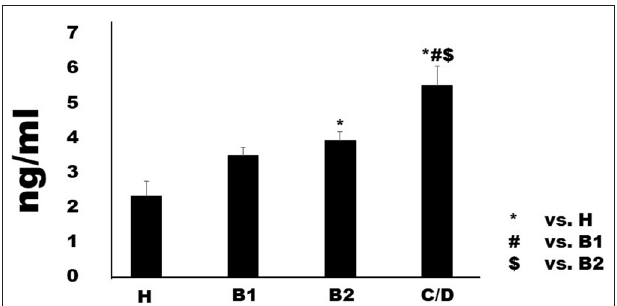
FIGURE 1 | Serum concentrations of intestinal fatty-acid binding protein in healthy Chihuahuas (H) and Chihuahuas with myxomatous mitral valve disease divided into three groups (B1, B2, and C/D). One-way ANOVA with post hoc Turkey-Kramer test. Significant difference was considered P < 0.05.